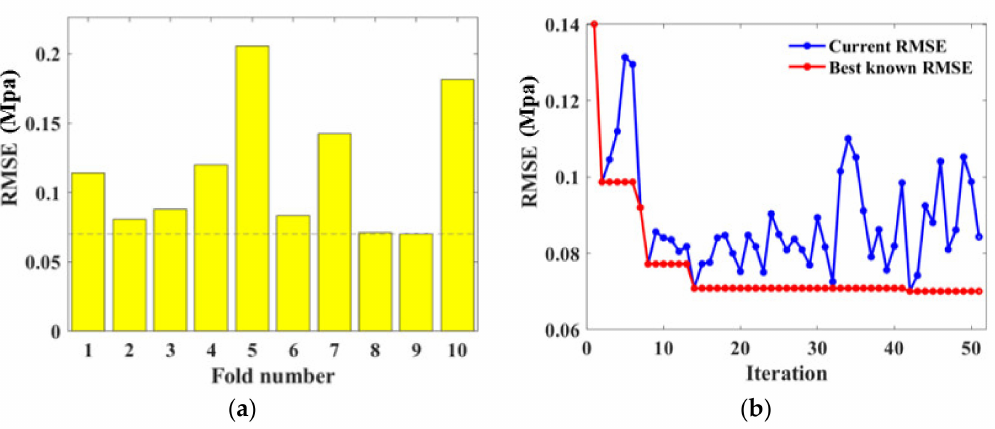
Figure 20. Hyperparameter tuning for RF: ( a ) RSME values obtained in 10 validation folds; ( b ) Itera- tion conducted at the 9th fold.